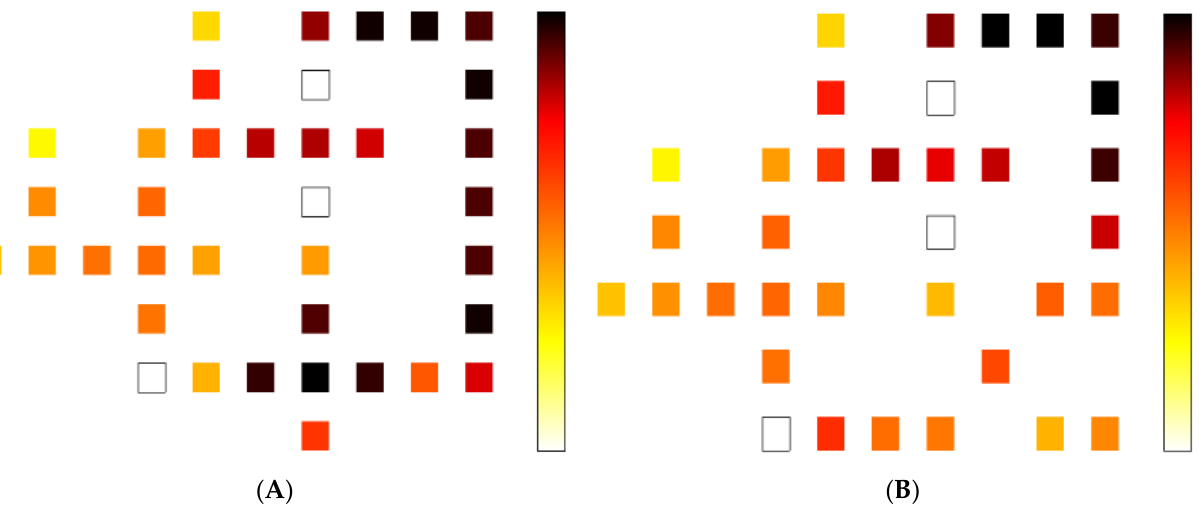
Figure 11. Thermal hotspots of the full adders ( A ) (FA-1) and ( B ) (FA-2) at 0.5 Ek.